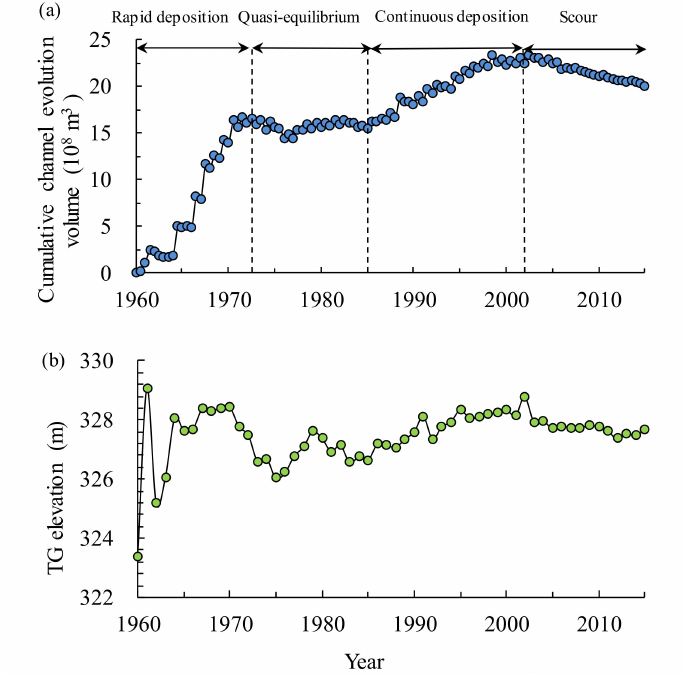
Figure 3. Variations in the cumulative channel evolution volume and the base level: ( a ) cumulative channel evolution volume; ( b ) Tongguan (TG)